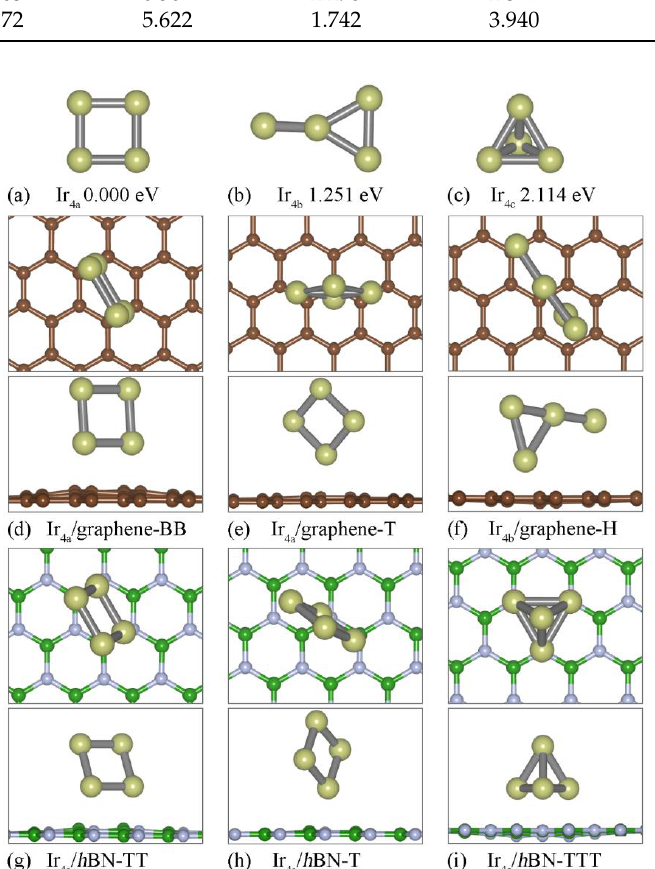
a stronger interaction between the cluster and the substrate and does not guarantee a higher stability. For example, as listed in Table 1, Ir 4c / h BN-TTT (Figure 2i) has a larger E b , along with a higher total energy.